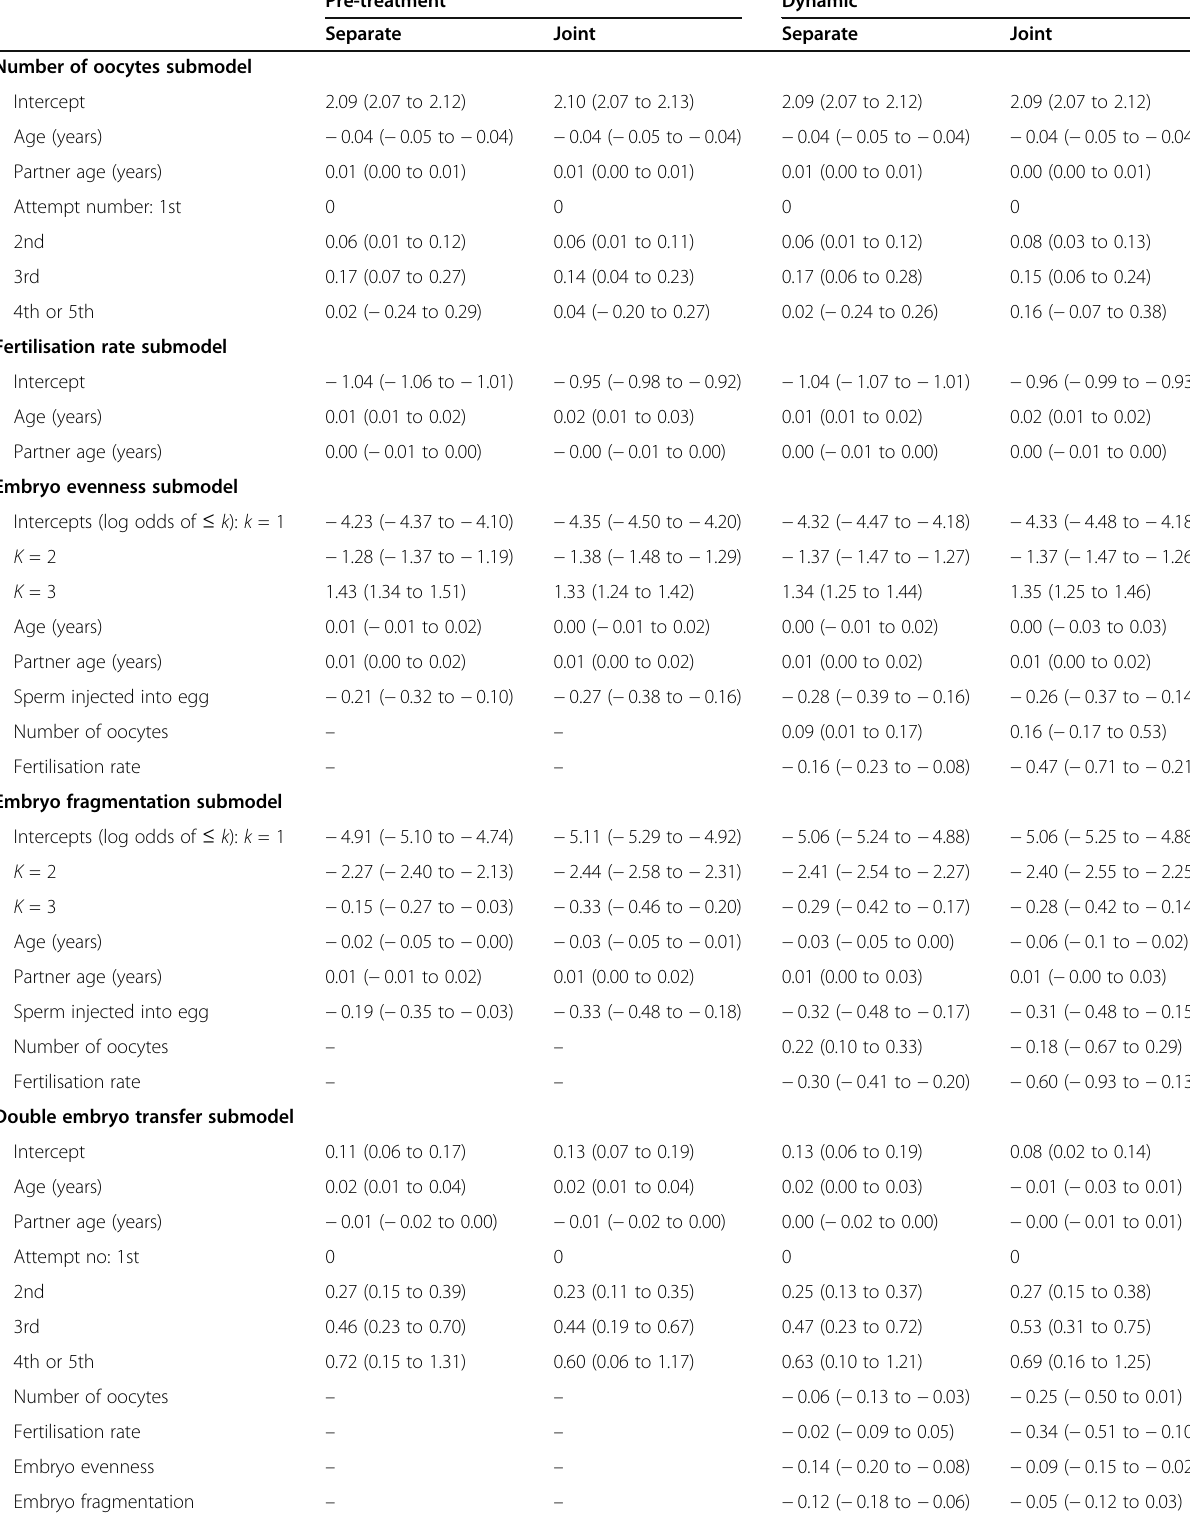
Table 2 Estimated regression coefficients (95% CIs) from the fitted